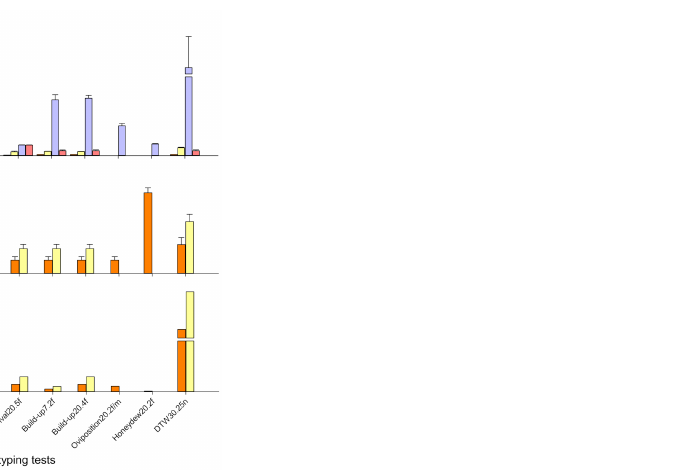
Figure 6. Relative time and space requirements for 11 phenotyping tests as implemented in the present study. ( A ) The time taken to evaluate phenotyping tests is presented for tests that were scored using the SES (i.e., damage ratings), for tests that included an evaluation of plant weight loss (as an indicator of tolerance), and for detailed evaluation of insect response variables (resistance). Time costs where counting and sorting could be replaced by drying and weighing of insects are also indicated (=resistance [biomass]). The time to set up bioassays is indicated in ( B ) with related space requirements in ( C ). Evaluation times were recorded during evaluation of the experiments in this study. Setup times for resistance tests were recorded during the present study with times to set up bulk testing estimated from normal operations at the IRRI entomology unit (2009–2015). All space and time requirements are for a single replicate of 16 test lines. Standard errors are indicated (N = 6 or